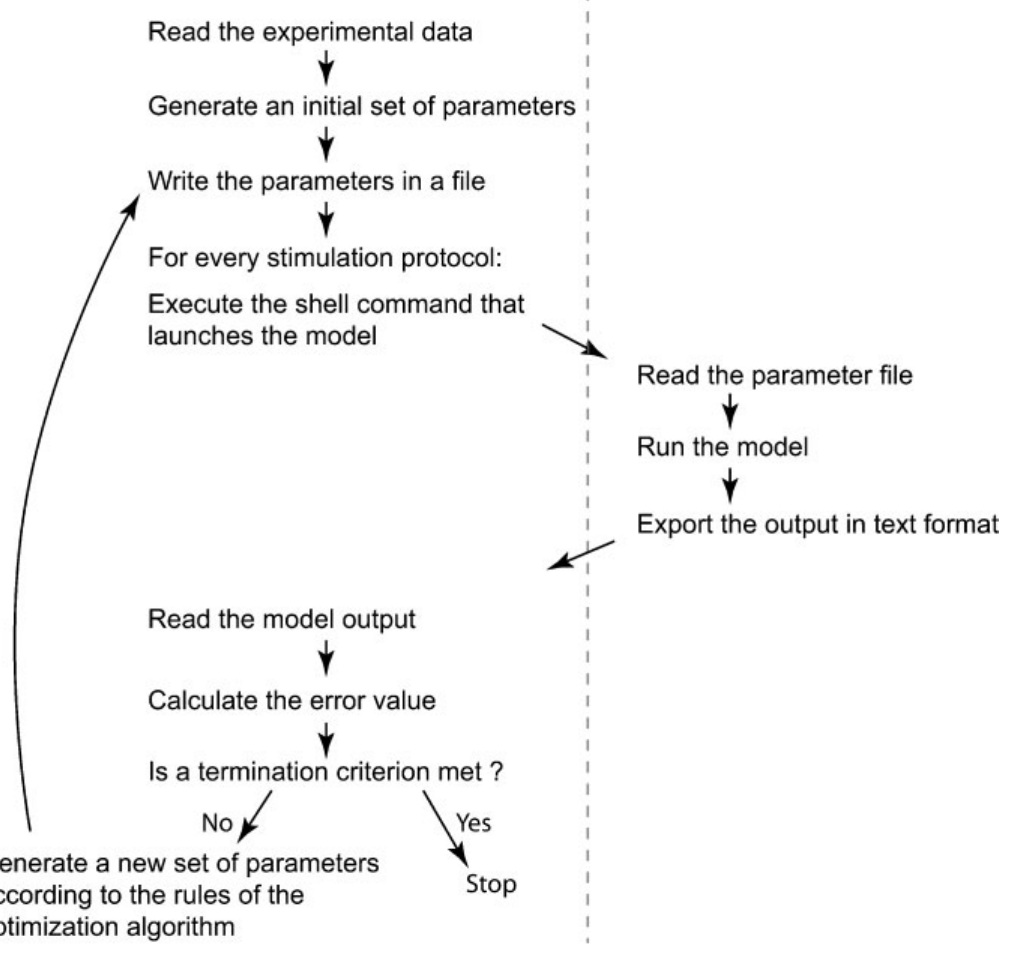
system. The next level that can be parallelized is outside Neurofitter’s control; one can parallelize the model itself, with the PGENESIS simu- lator (De Schutter and Beeman, 1998) or with NEURON (Migliore et al., 2006). Neurofitter allows the user to mix the different levels of paral- lelization if necessary, but this can be very complicated to set up on